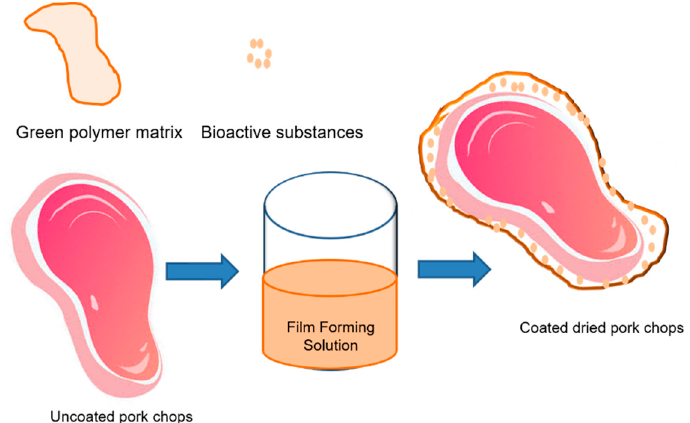
Figure 1. Schematic drawing for exemplifying the dipping technique of pork chops.